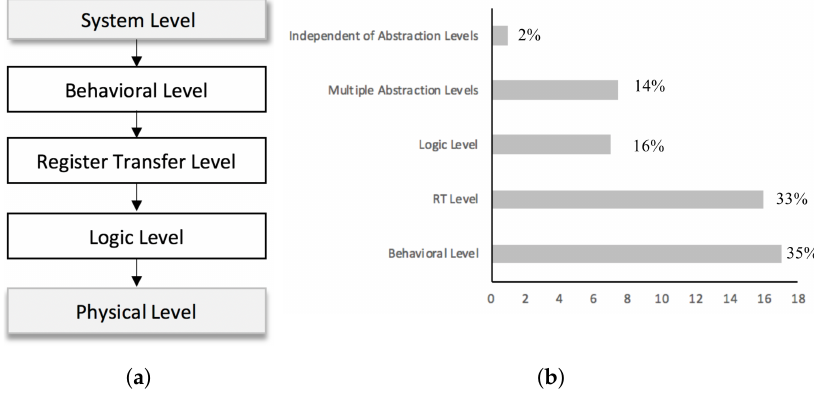
Figure 6. Overall results based on abstraction levels. ( a ) Abstraction levels; ( b ) Distribution of papers based on abstraction